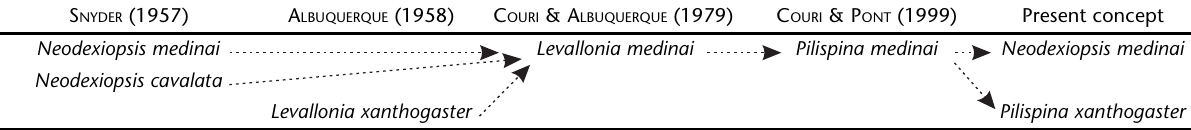
Table I. Morphological differences between N. medinai and P. xanthogaster based on the examination of type material. Character Apical scutellar setae related to the sub-basal ones Length of the gena related to the flagellum Number of preapical setae on posterior femur Stripes on mesonotum Color of legs Number of AD setae on middle third of posterior tibia Number of PD setae on middle third of posterior tibia Median seta on posterior tibia